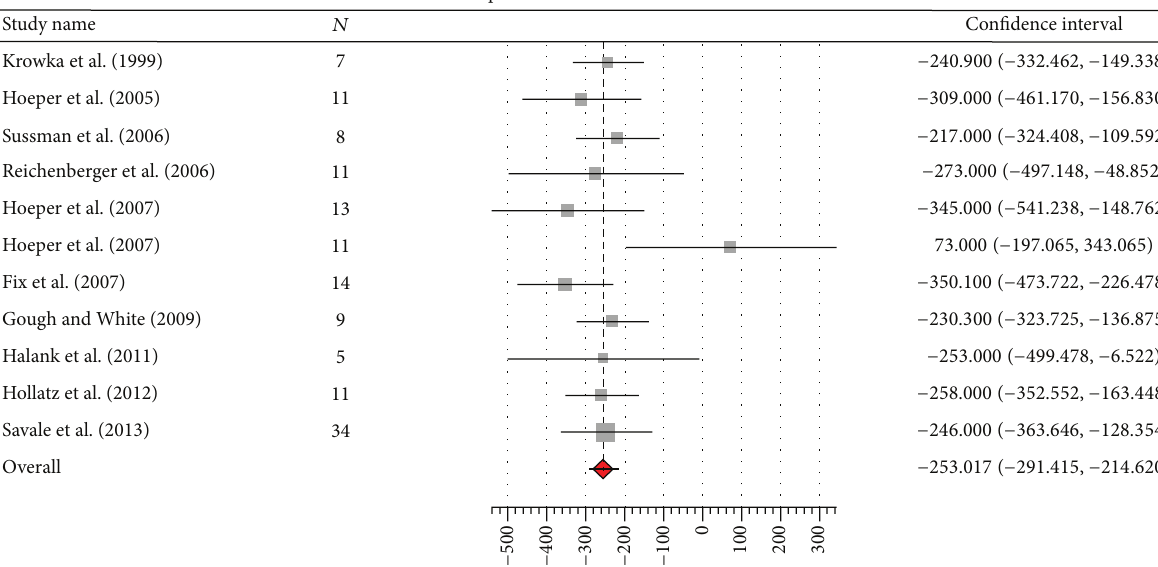
Figure 4: Effect of pulmonary arterial hypertension specific therapy on pulmonary vascular resistance (dynes ⋅ sec/cm 5 ).